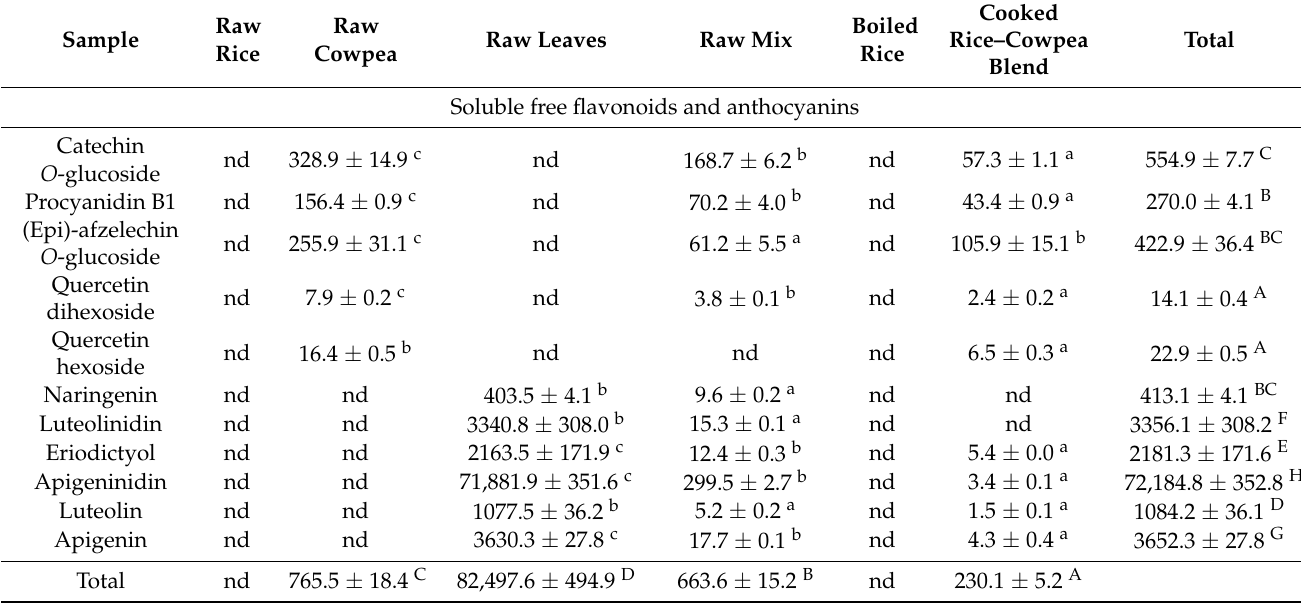
Key: Results are presented as means ± standard deviation of triplicates. “nd” means not detected. Catechin O -glucoside and (epi)afzelechin O -glucoside were expressed as catechin equivalents. Quercetin dihexoside and quercetin hexoside were expressed as quercetin equivalents. Luteolinidin, apigeninidin, eriodictyol, naringenin, luteolin, and apigenin were expressed as naringin equivalents. Units of all measurements are expressed as µ g/g sample, dry weight basis. Values in a row with different superscript letters were significantly ( p < 0.0001) different from each other. Significant differences among means of measured variables are shown by lowercase superscripts, while significant differences among means of total values are denoted by uppercase